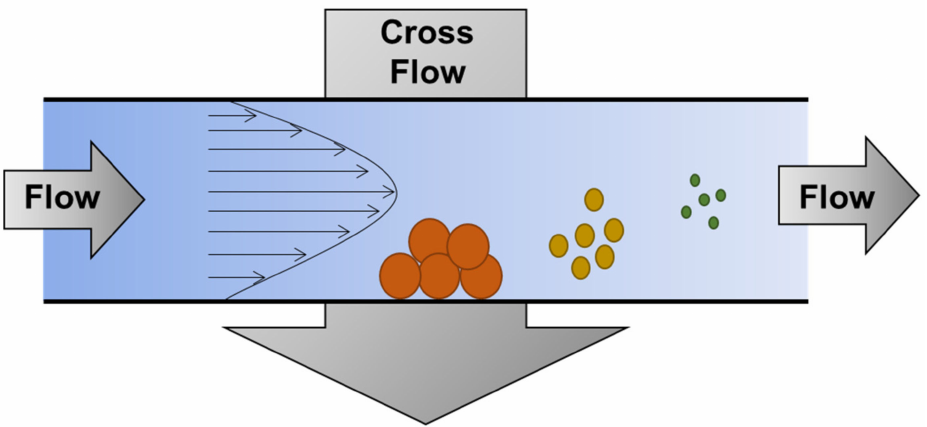
Figure 3. Scheme of asymmetrical flow field-flow fractionation